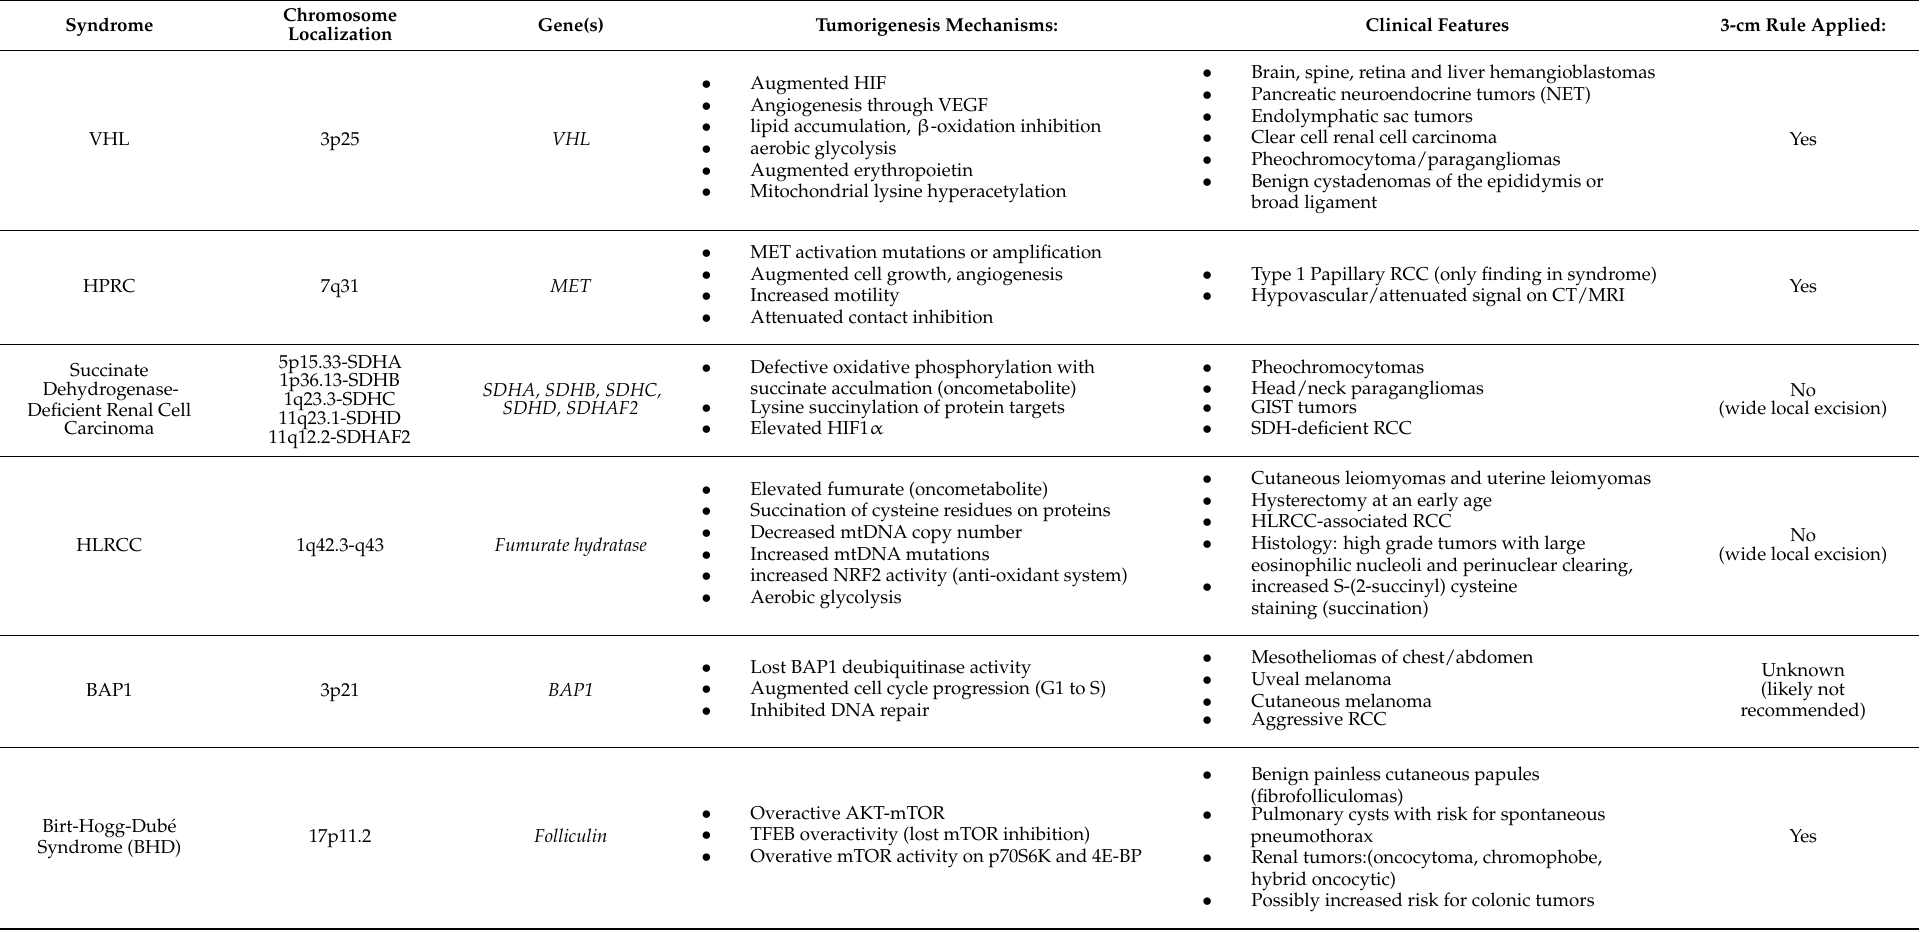
Table 1. Genetic alterations, tumorigenesis mechanisms, clinical features and surgical management of renal lesions found in hereditary renal cell carcinoma